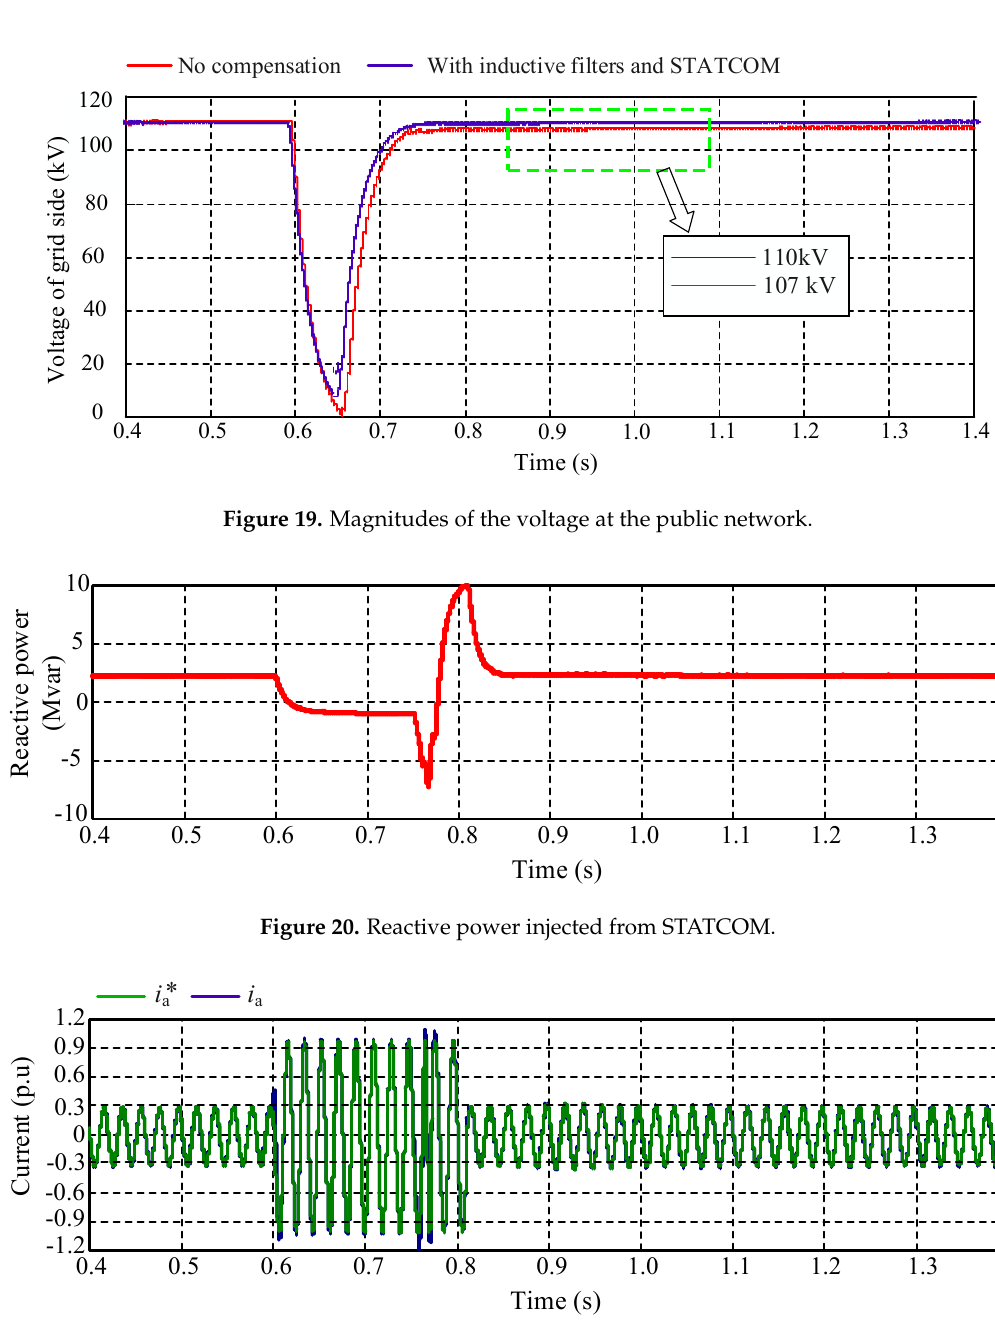
Figure 21. Output current and command current of the STATCOM.